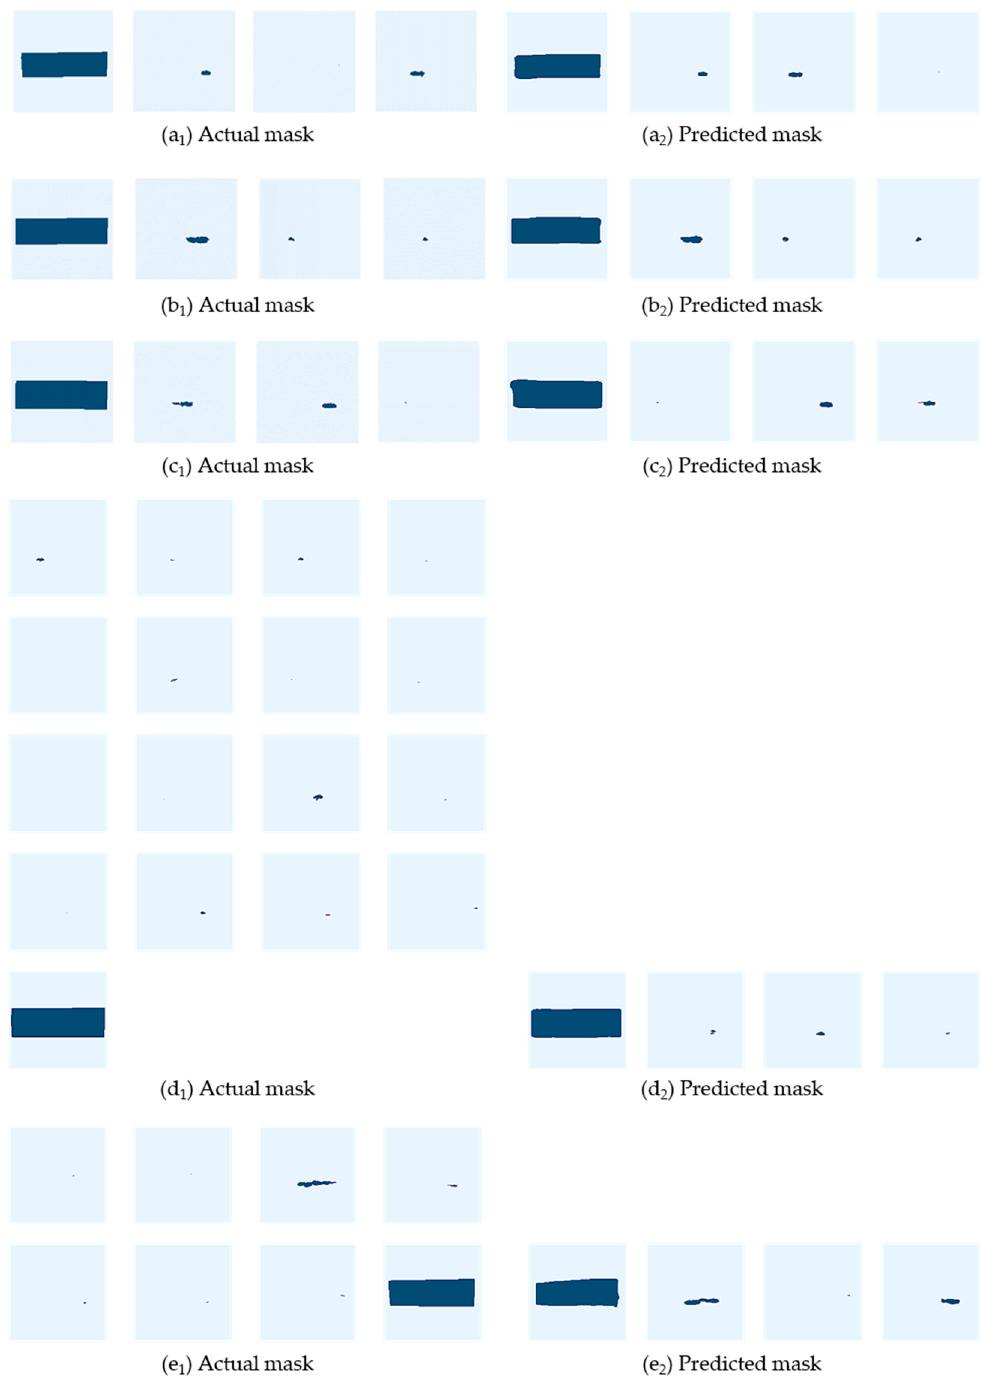
Figure 14. Examples of actual mask and predicted mask.